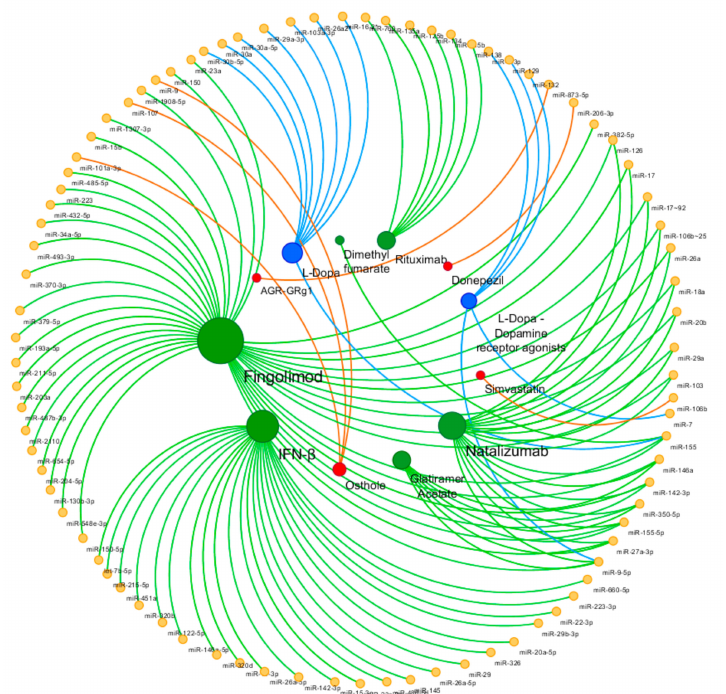
Figure 1. Circular view of microRNAs (miRNAs) and related drugs. Yellow nodes represent miRNAs, green nodes represent multiple sclerosis (MS) disease-modifying therapies, blue nodes represent Parkinson’s disease (PD) treatments, and red nodes represent AD treatments. The color of edges is associated to neurodegenerative diseases (NDDs), and the size of the nodes is proportional to the degree of the nodes (number of incoming and outcoming edges). The network is visualized using Cytoscape v3.7.1. (Institute for Systems Biology, Seattle, WA,